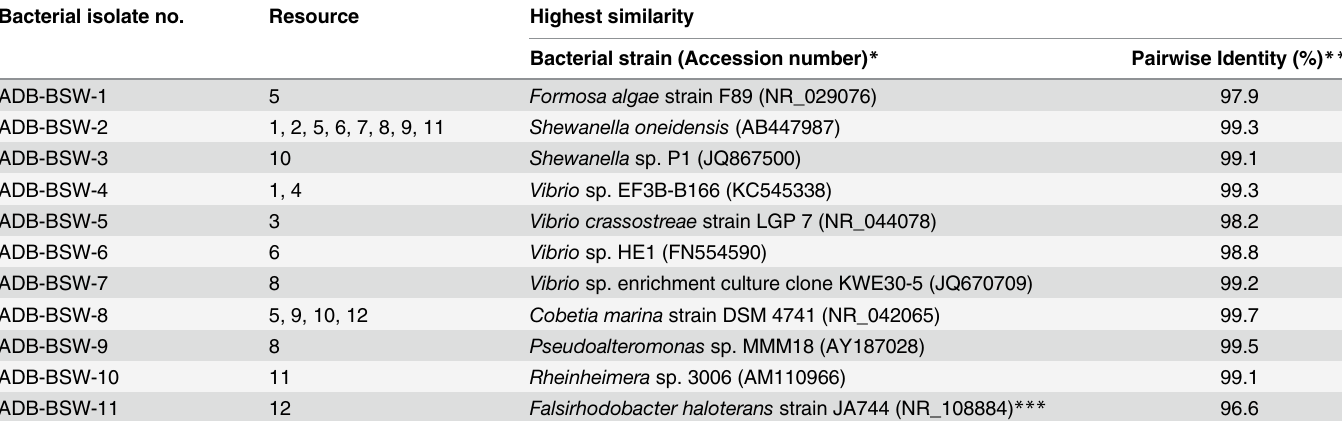
Table 1. 16S rRNA gene sequence similarity of bacterial isolates with database strains. Bacterial isolate no.